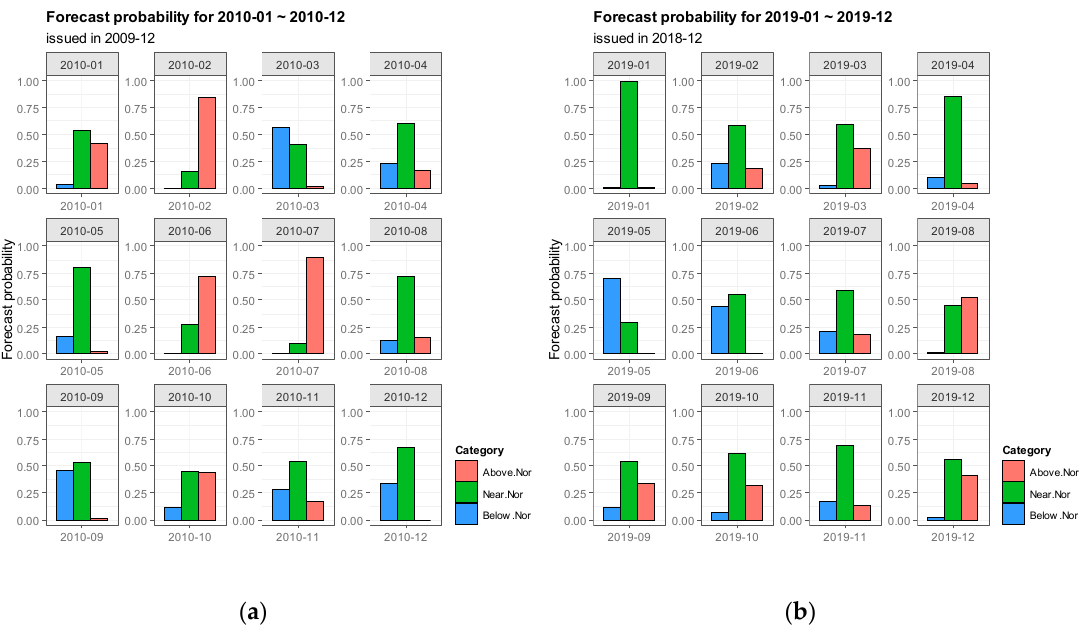
Figure 16. Tercile probability information for monthly precipitation forecasts issued in ( a ) December 2009 and ( b ) December